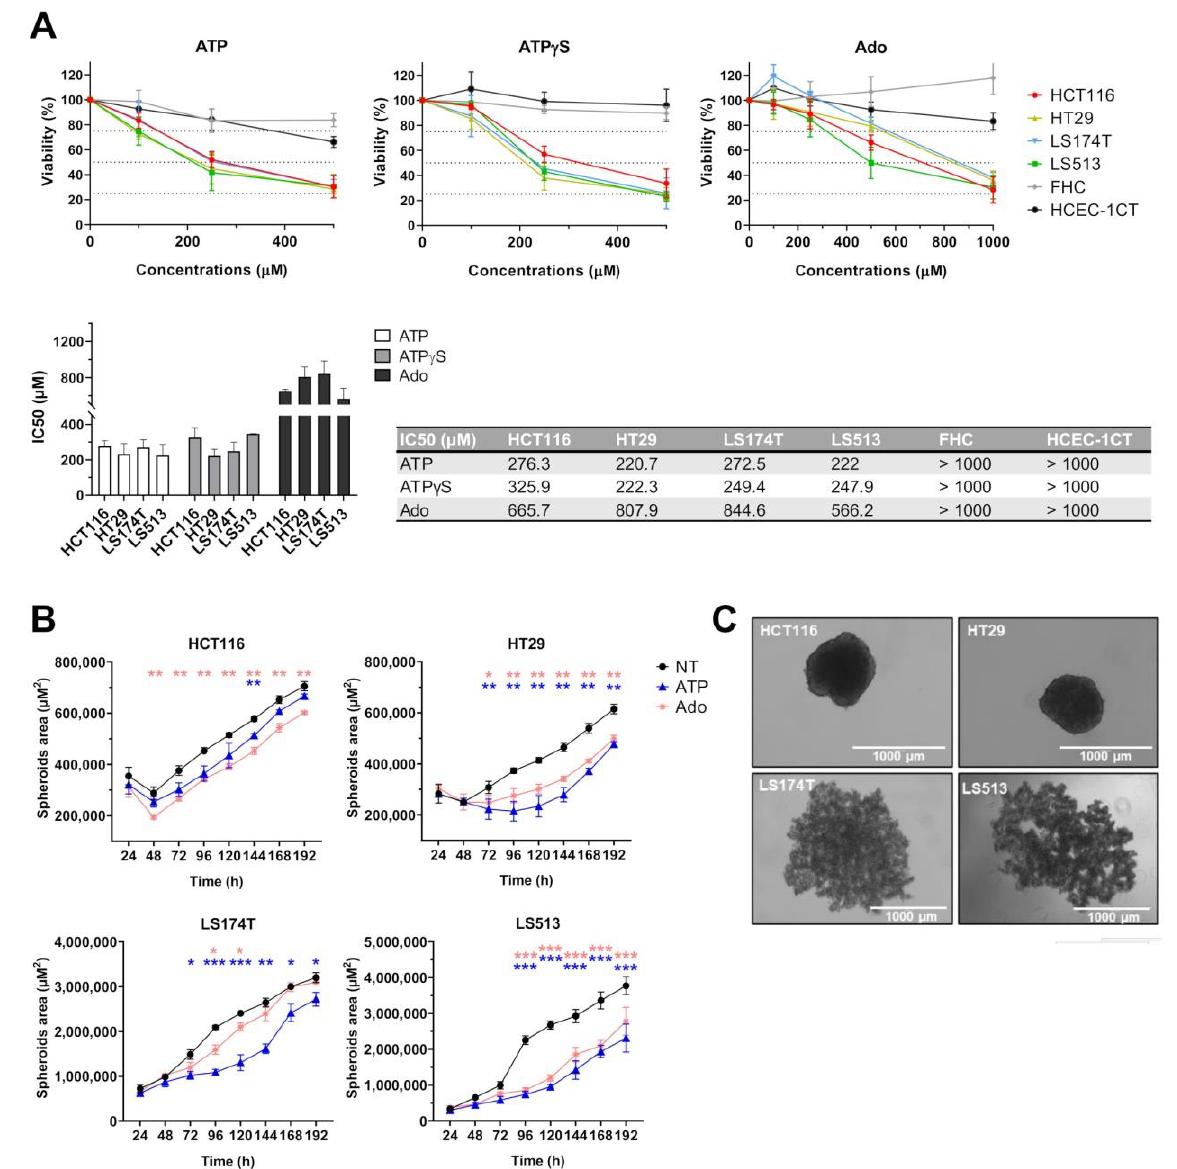
Figure 3. Effect of purine molecules on 2D cell viability and 3D spheroid growth. ( A ) CRC (HCT116, HT29, LS174T, LS513) and non-tumorigenic colonic (FHC, HCEC-1CT) cell lines were treated for four days with increasing concentrations of ATP, ATP γ S and adenosine (Ado) (range 0–500 µ M) and cell viability assessed by the CellTiter-Glo 2.0 assay (upper panels; n ≥ 3). IC50 mean values were calculated and are indicated in the lower panels (histograms and table). ( B ) 3D cell viability assay. CRC (HT29, HCT116, LS174T and LS513) carcinoma cells were cultured in 3D and then treated with 250 µ M ATP or 250 µ M adenosine (Ado). Growth kinetics was assessed by microscopy (daily pictures) and the area of each spheroid determined by ImageJ. Data are expressed as spheroid area mean +/ − SD ( n = 3); p -values were calculated using Student’s paired t -test: * p < 0.05, ** p < 0.01, *** p < 0.005. ( C ) Representative images of untreated CRC spheroids taken after 96 h of culture in low attachment plate.